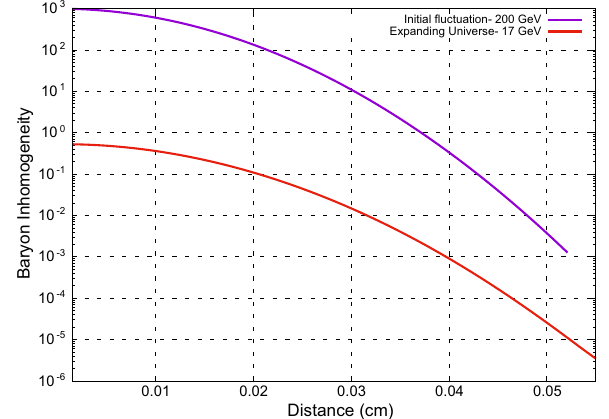
Fig. 3 The decay of the fluctuation is shown in logscale between 200 and 17 GeV as the quarks are predominantly surrounded by neutrinos. The fluctuation is smallerat higher temperatures and spreads out further as temperature